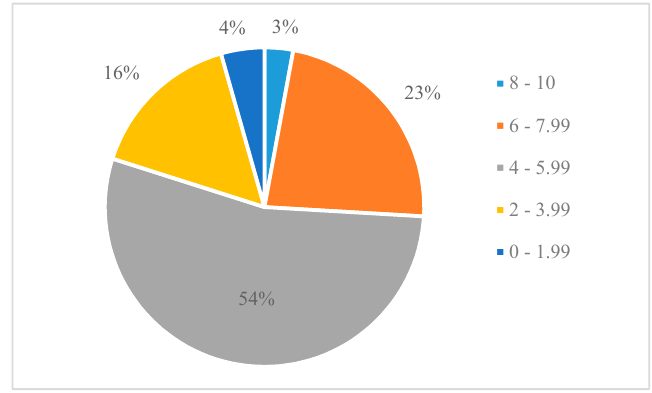
Figure 7. The distribution percentage of FLQ scores of all counties.